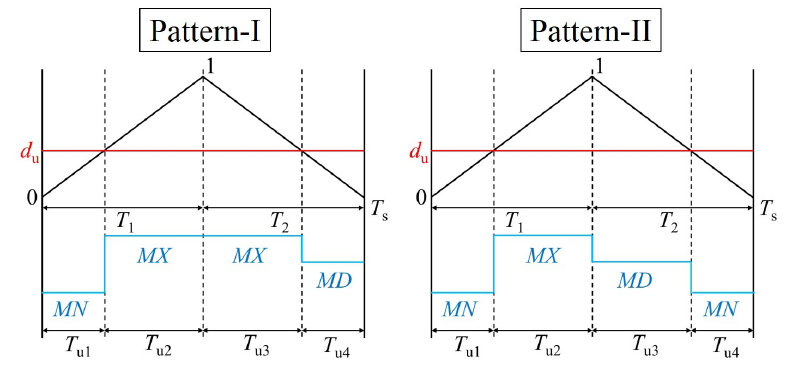
Figure 2. Switching states in Pattern I and Pattern II in the direct duty ratio pulse width modulation (DDRPWM)